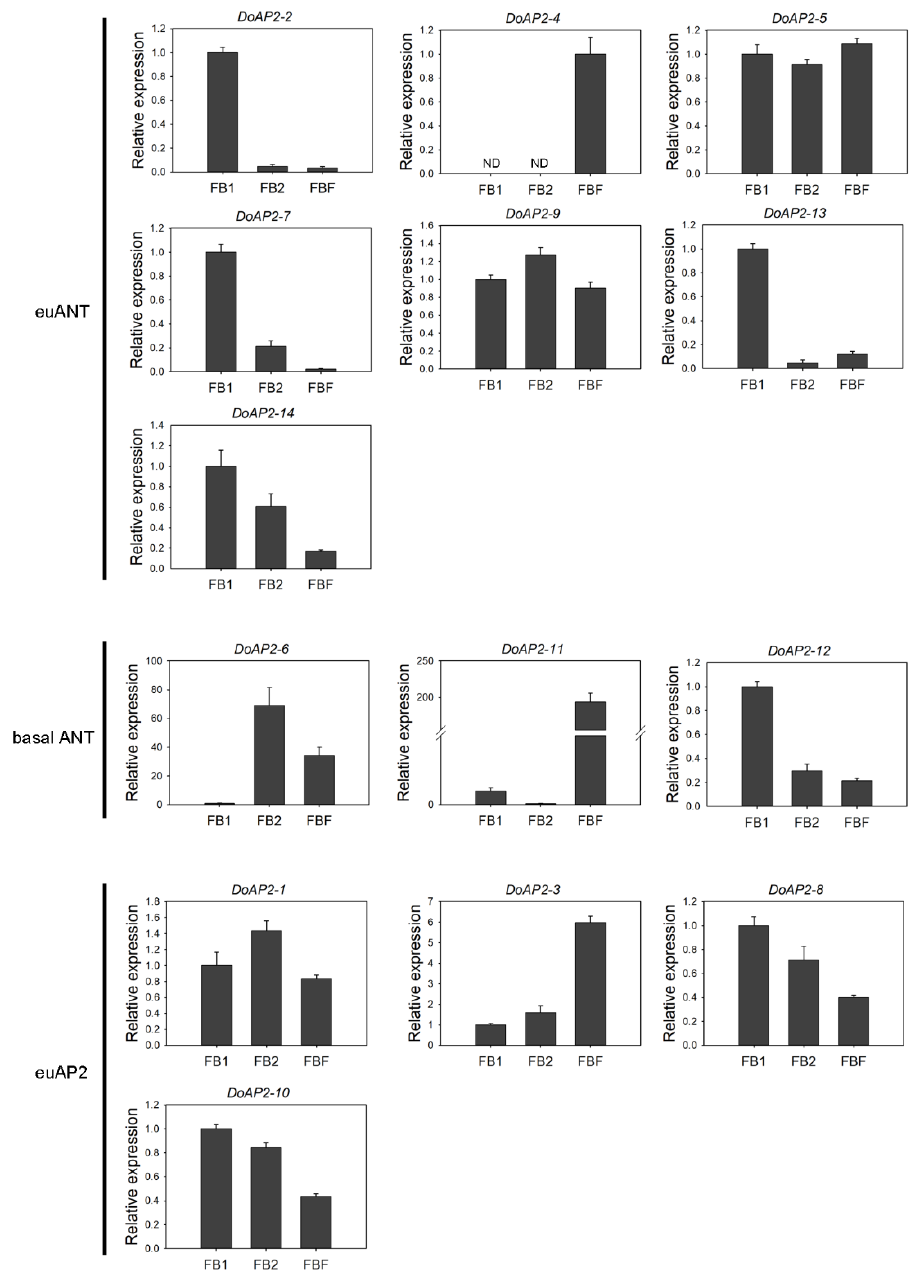
Figure 5. Expression analysis of DoAP2 genes during flower development by qRT-PCR. FB1, small flower buds (about 5 mm long); FB2, medium flower buds (about 10 mm long); FBF, fully bloomed flowers. Each data bar represents the mean ± standard deviation (SD) of three biological replicates ( n = 3). ND, not detected.